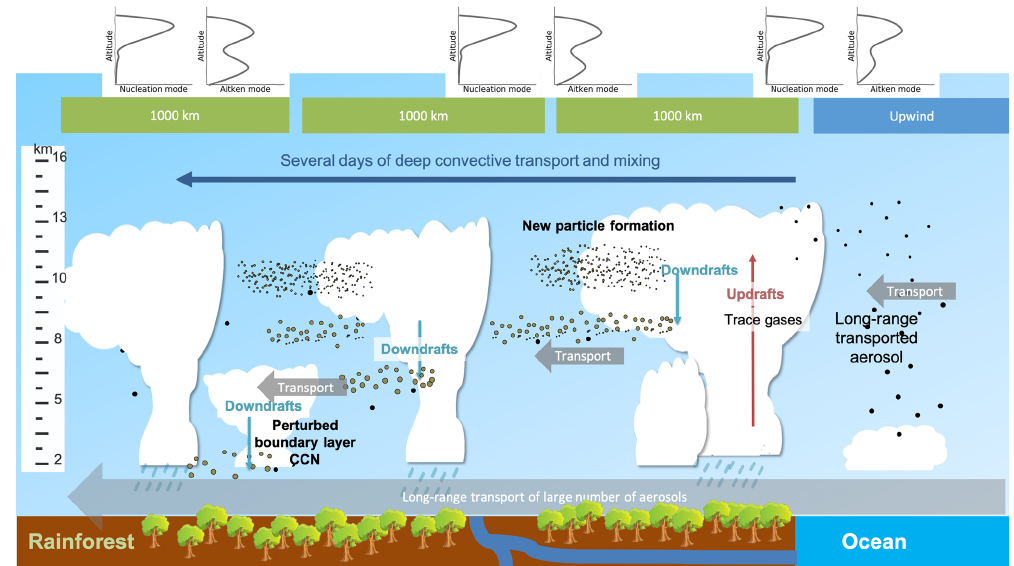
Figure 14. A schematic diagram of downward transport and mixing of aerosols associated with NPF. The nucleation and Aitken mode aerosol profiles in upper panels are example number concentrations in the upwind, within and in the downwind of the simulated 1000km by 400km